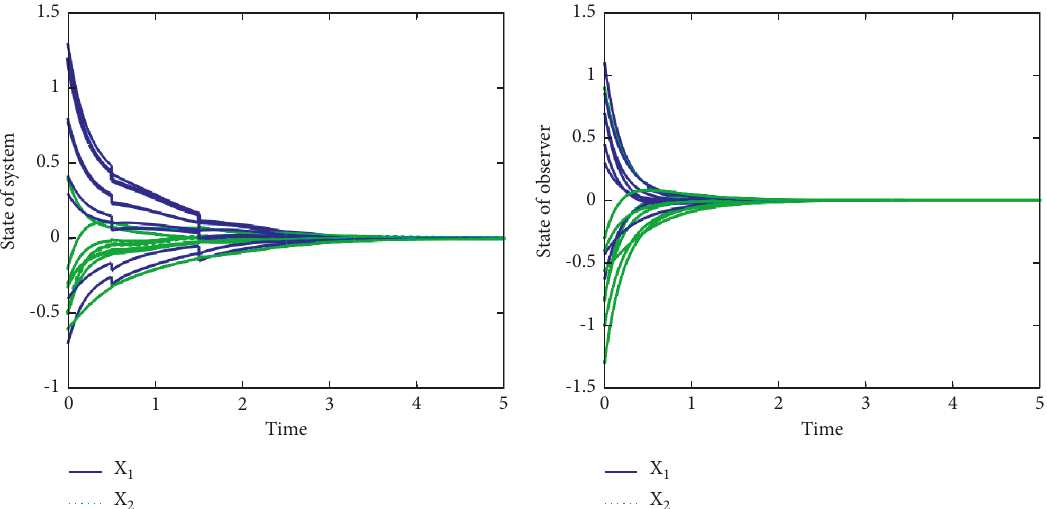
Figure 5: The quasi-synchronization. State diagram of 8 nodes of observation system (1) and system (2), when α